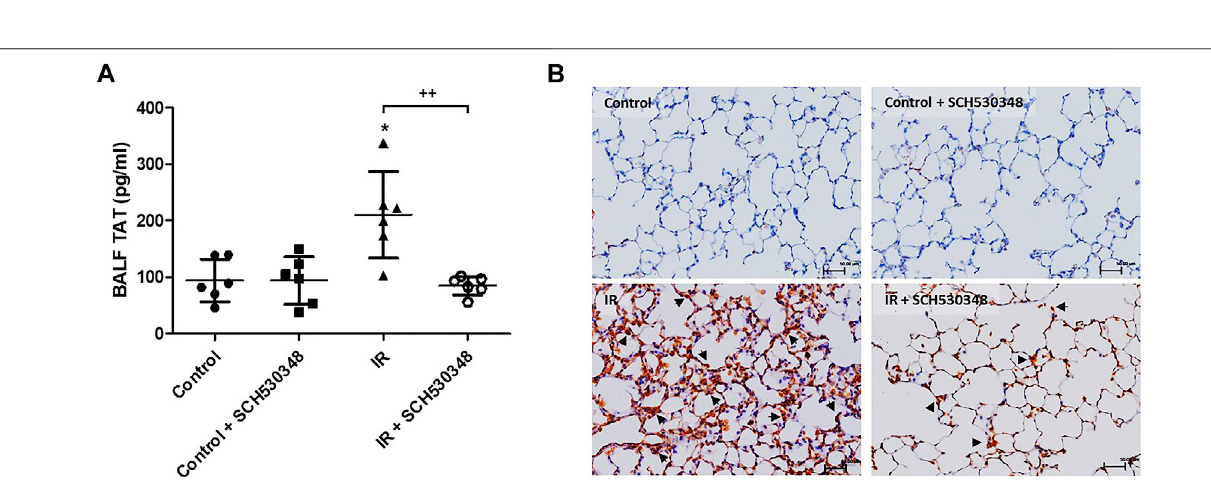
Frontiers in Pharmacology |